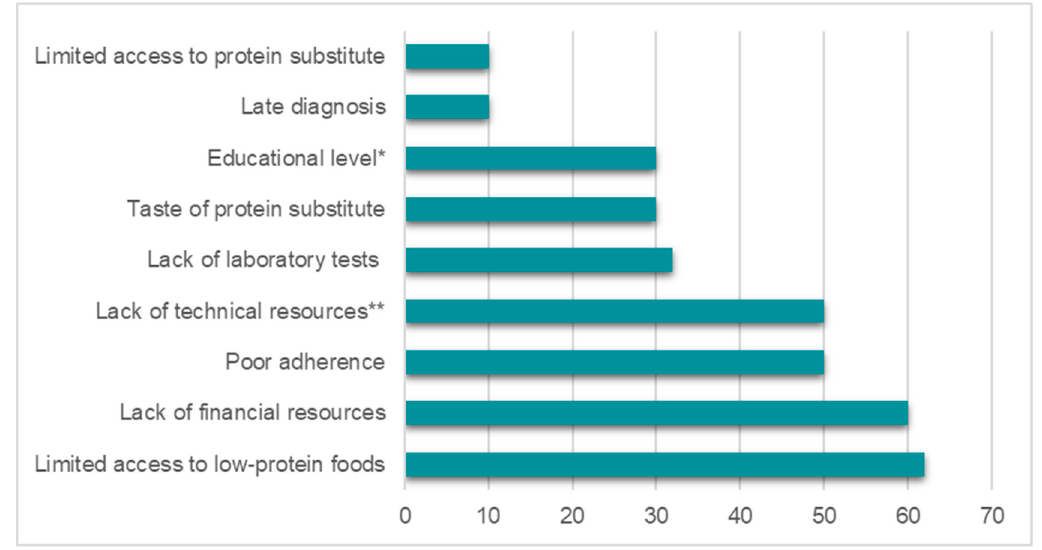
Figure 4. Barriers to treatment most commonly perceived by the respondents ( n = 22). Values represent the median scores assigned by the respondents. * Educational level of patients and caregivers; ** Technical resources required or desirable to manage the diet, such as a local database of the Phe content of foods and specialized nutrition